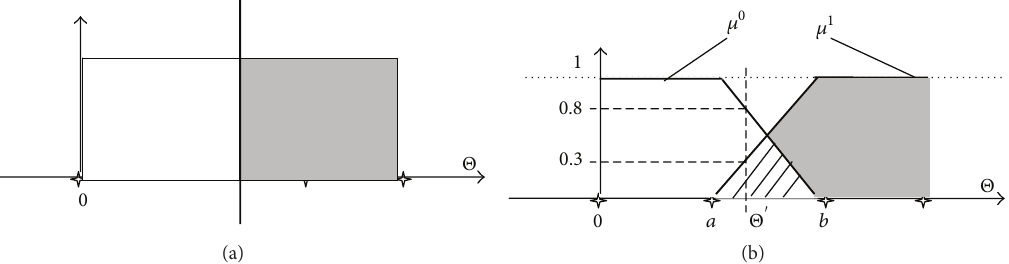
Figure 2: Illustration of the ideas of “crisp” and “fuzzy” technical states.